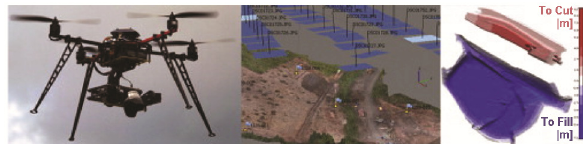
Fig. 9. An Unmanned Aerial Vehicle (UAV) for mobile and autonomous acquisition of for 3D mapping of built infrastruc- ture (Siebert, Teizer